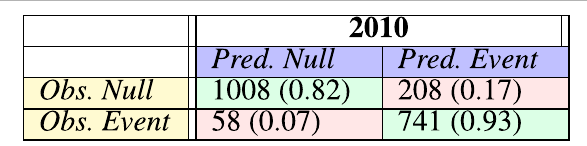
TABLE 3 | Confusion matrices of neural network classi fi cation considering only events that the Smith et al. catalog could have identi fi ed.